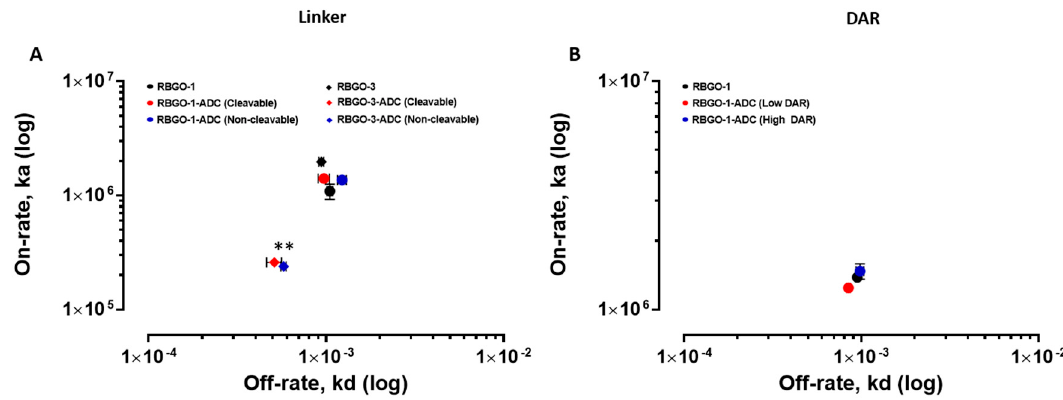
Figure 6. Antibody–antigen kinetics are not affected by the type of linker used or the drug to antibody ratio. Single-cycle kinetics experiments were performed. ( A ) RBGO1 antibody ( ● ), RBGO1-ADC (Cleavable; ● and Non-cleavable; ● ) were exposed to rRAGE (2.5 to 200 nM). RBGO3 antibody ( ), RBGO3-ADC (Cleavable; (cid:117) and Non-cleavable; (cid:117) ) were exposed to the aa198-217 peptide (2.5 to 200 nM). ( B ) RBGO1 antibody ( ● ), RBGO1-ADC (Low DAR; ● and High DAR; ● ) were exposed to rRAGE (2.5 to 200 nM). On-rates and off-rates, k a and k d were determined using a one-to-one binding model. Data displayed are mean ± SD ( n = 3). ** p <0.01 for k a compared to the unconjugated antibody.